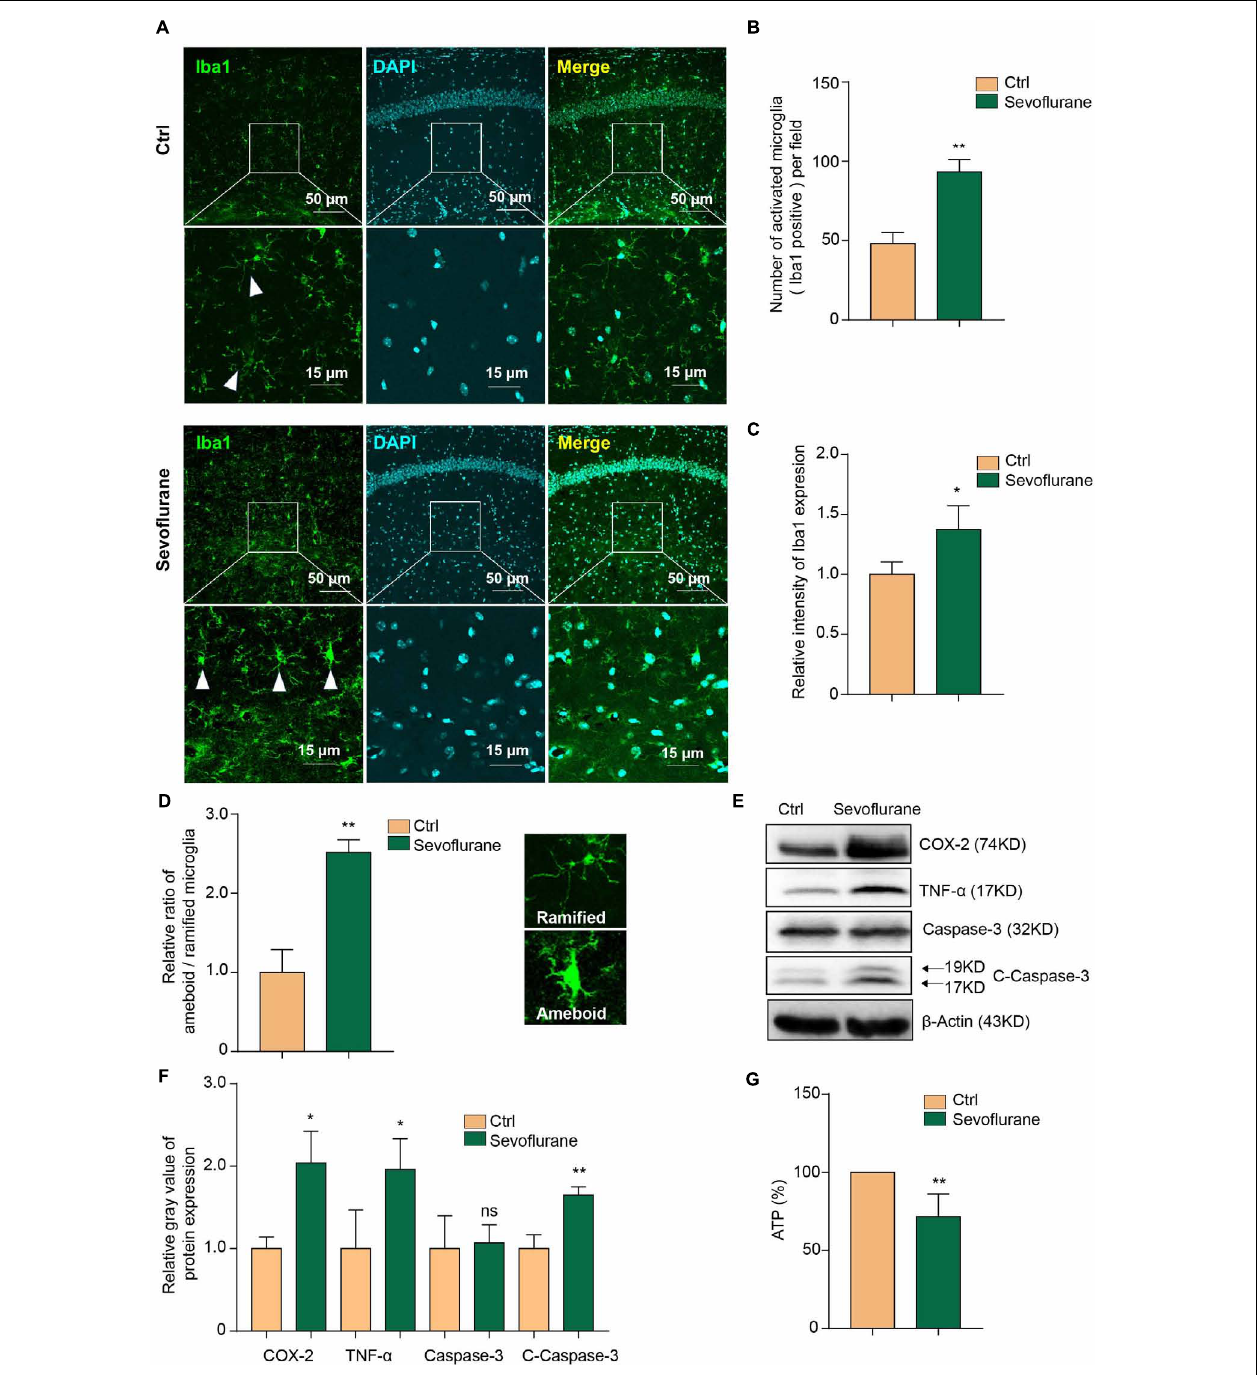
FIGURE 1 | Sevoflurane induces inflammation and decreases the ATP concentration in microglia. (A) Microglial cells were activated in the mouse hippocampus after 3% sevoflurane treatment, as detected by Iba1 immunofluorescence staining. The scale bar indicates 50 (upper row) and 15 µ m (lower row), respectively. (B) Quantification of Iba1 staining positive (Iba1 +) cell numbers and (C) intensity in hippocampal tissue from control- and sevoflurane-treated mice. (D) We morphologically classified the activated (amoeboid) or surveying (ramified) cells of Iba1 positive (Iba1 +) microglia to further perform the statistics of the ratio between amoeboid/ramified. (E) Western blot analysis indicated that 3% sevoflurane treatment for 6 h induced upregulation of the inflammatory factors COX-2 and TNF- α and activation of caspase-3 in mouse primary microglia. (F) Statistics of the relative gray value indicating the protein expression in panel (E) . (G) The concentration of ATP was decreased in sevoflurane-treated microglia. Ctrl means control. β -Actin served as a loading control. Student’s t -test was used to determine differences in panels (B–D,F,G) . The data shown are the means ± SD, n = 3 in panels (B–D,F) . n = 4 in panel (G) . * or ** means p < 0.05 or 0.01. ns means no significant difference compared with the control